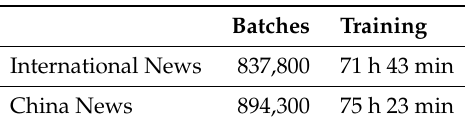
Table 2. Training